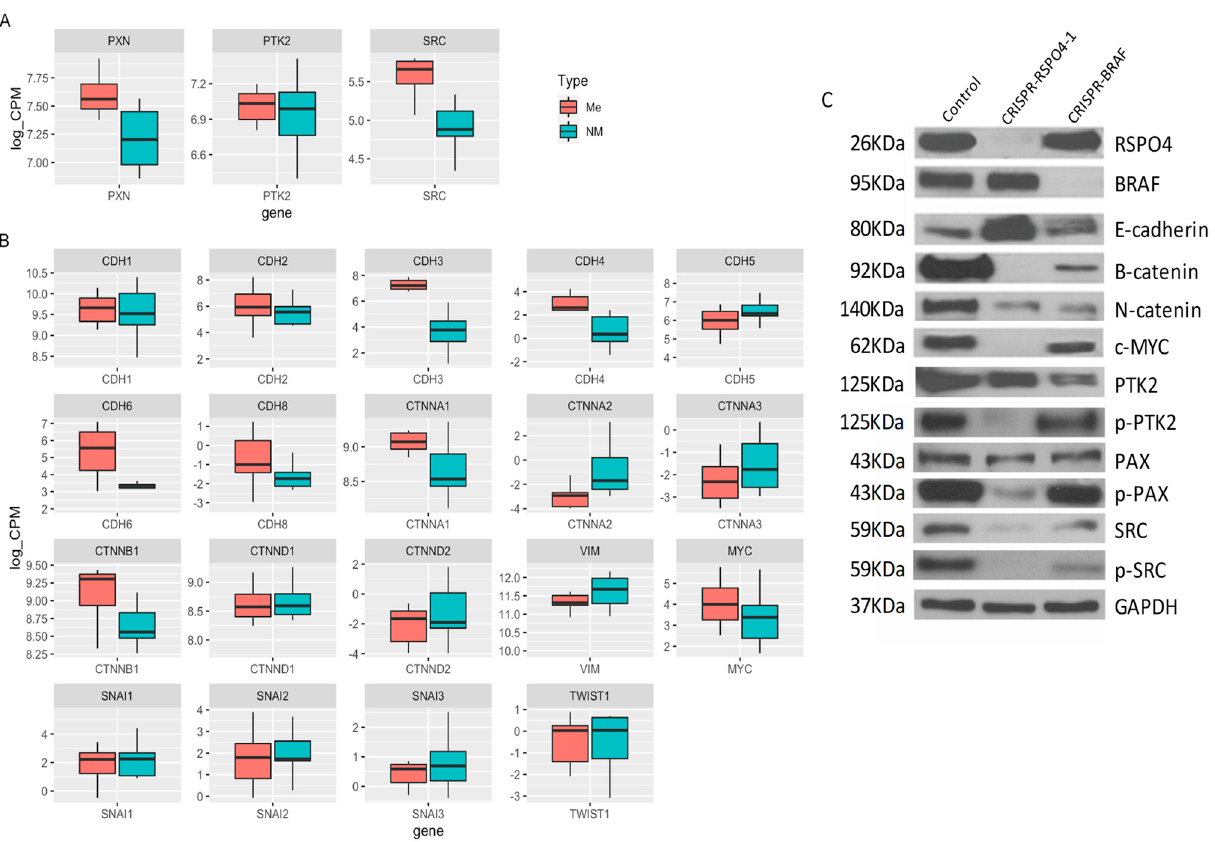
Figure 7. CRISPR-RSPO4 knockout reduce adhesion potential in PTC cell lines. ( A ) Box plot showing the gene expression data from PTC patient’s samples considering genes from focal adhesion network, ( B ) RSPO and BRAF signaling and ( C ) Cell lysates from control, CRISPR-RSPO4, and CRISPR-BRAF of metastatic cell line were immunoblotted with antibodies against Rspo4, Braf, E-cadherin, B-catenin, α N-catenin, Y69-phospho-cMyc, PTK2 (FAK), Y397-phospho-PTK2, Paxilin, 118Y-phospho-paxillin, Src, 416Y-phospho-Src, and Gapdh as an internal control. Error Bars represent SD from two experiments.